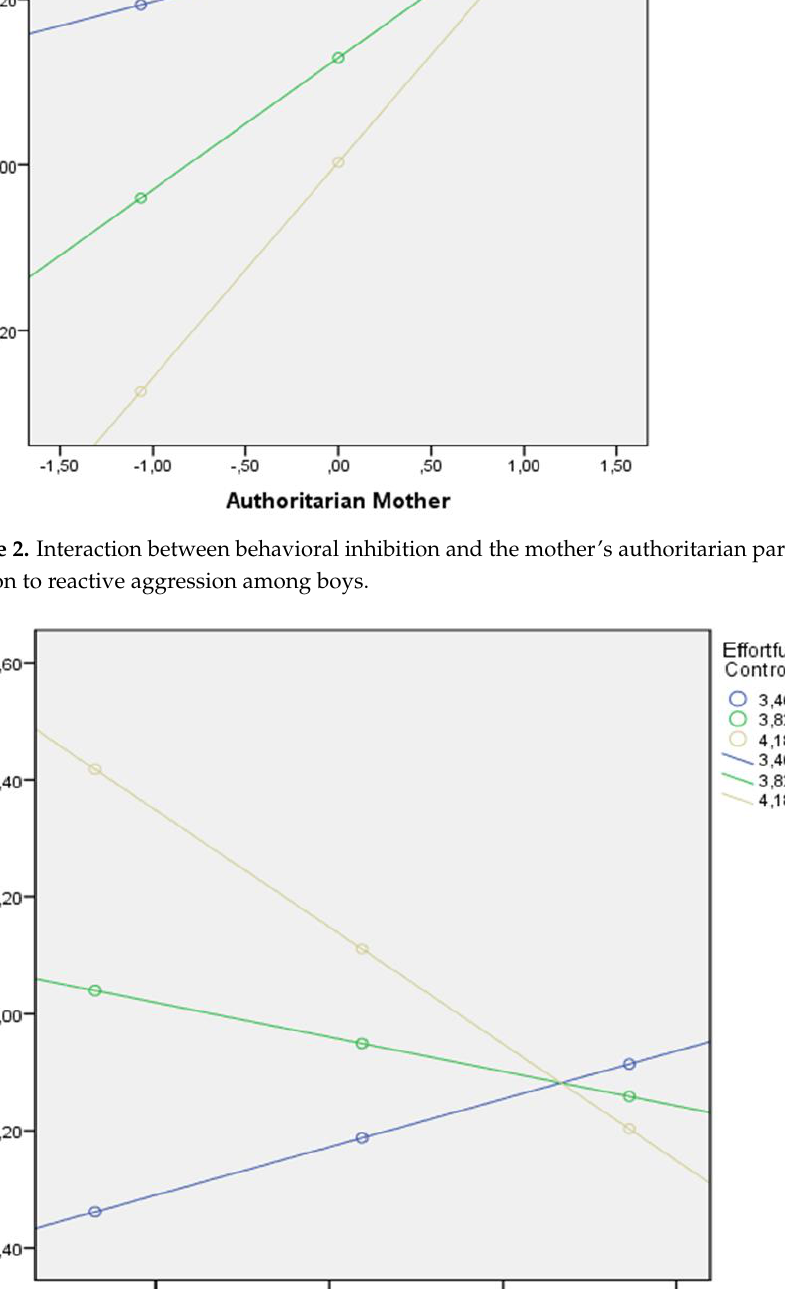
Figure 3. Interaction between effortful control and the mother ’ s authoritative parenting style in re- lation to proactive aggression among girls. relation to proactive aggression among